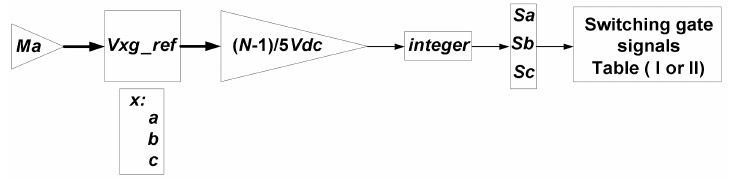
Figure 3. Operating principle of the NVM technique. Four different space vector diagrams representing the function of the three-phase MLI with four valid switching sequences are shown in Figure 4.